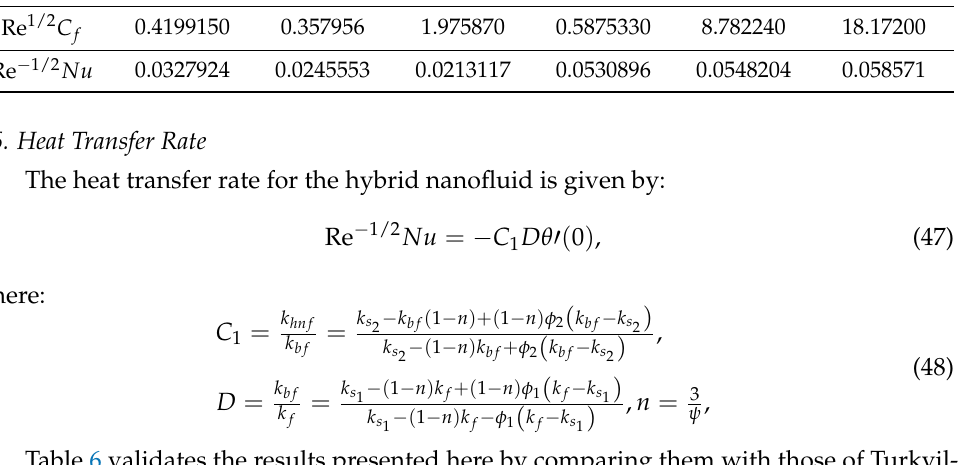
Table 5. Numerical outcomes of drag force and the heat transfer rate under disk fluctuation and keeping [26] K vs = 0.5, λ = 0.5, Ω = 0.5,Pr = 1, α = 0.3, K s = 0.5, K c = 0.5. S = −